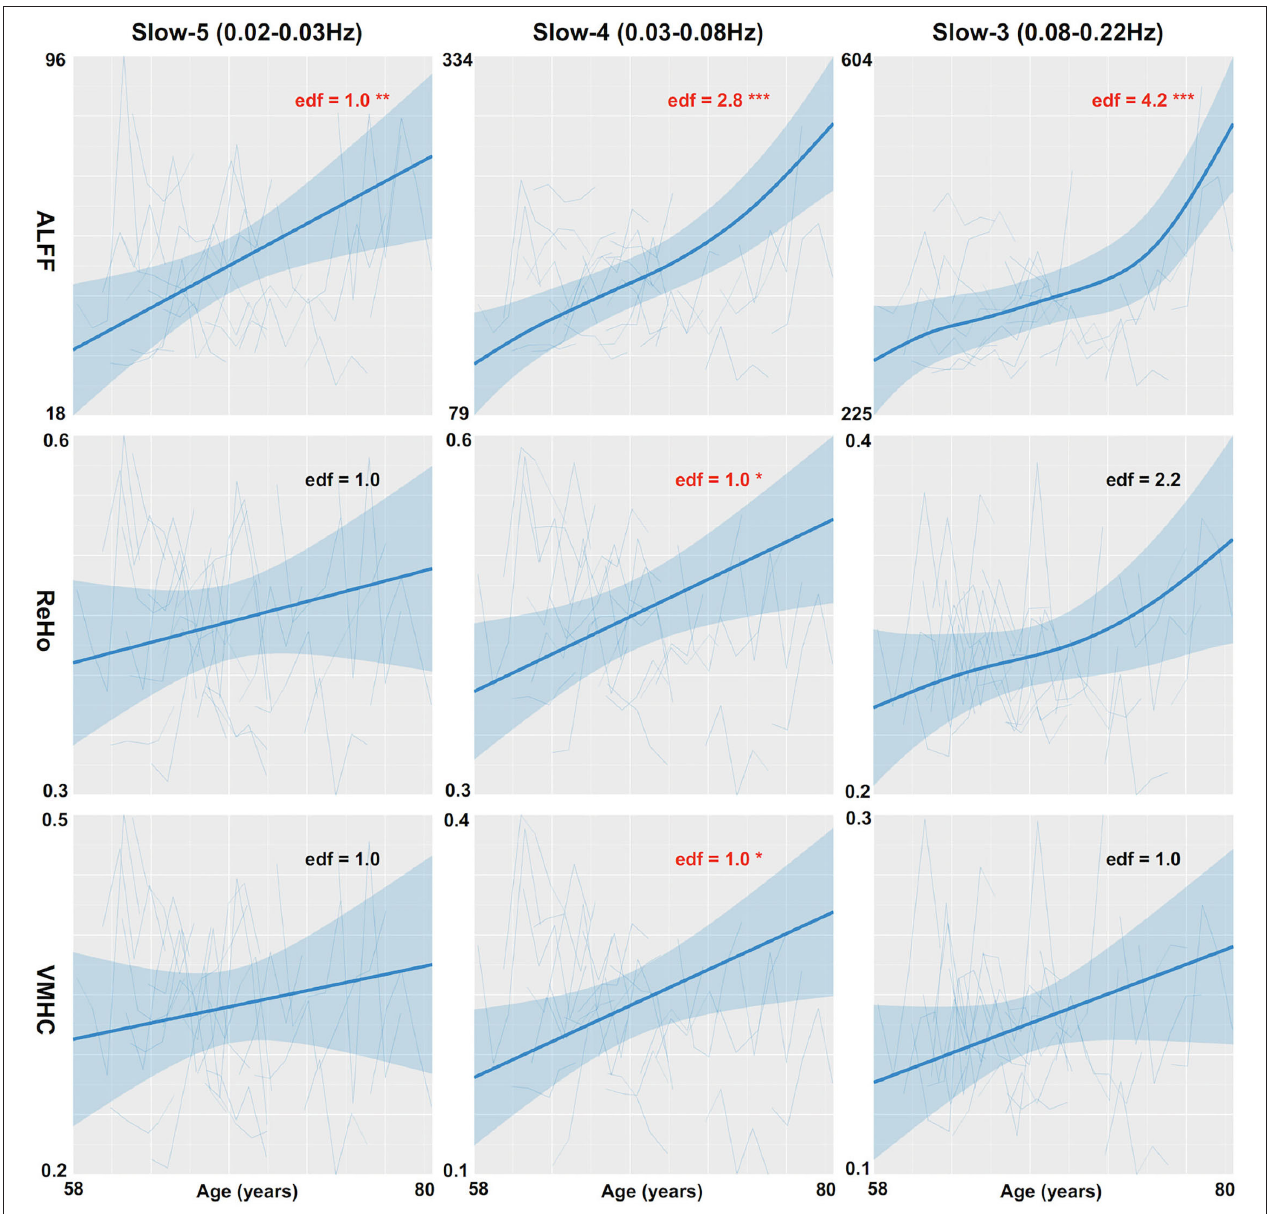
FIGURE 1 | Global mean measurements of cortical spontaneous activity (CSA) are regressed against age. Three CSA metrics including ALFF (the top row), ReHo (the middle row), and VMHC (the bottom row) are plotted for each individual and modeled into the aging curves with the 95% CI (the shadow areas). The aging curve modeling is applied to three different frequency bands including slow-5 (the left column), slow-4 (the middle column), and slow-3 (the right column). edf, effective degree of freedom; * p < 0.05; ** p < 0.01; *** p <